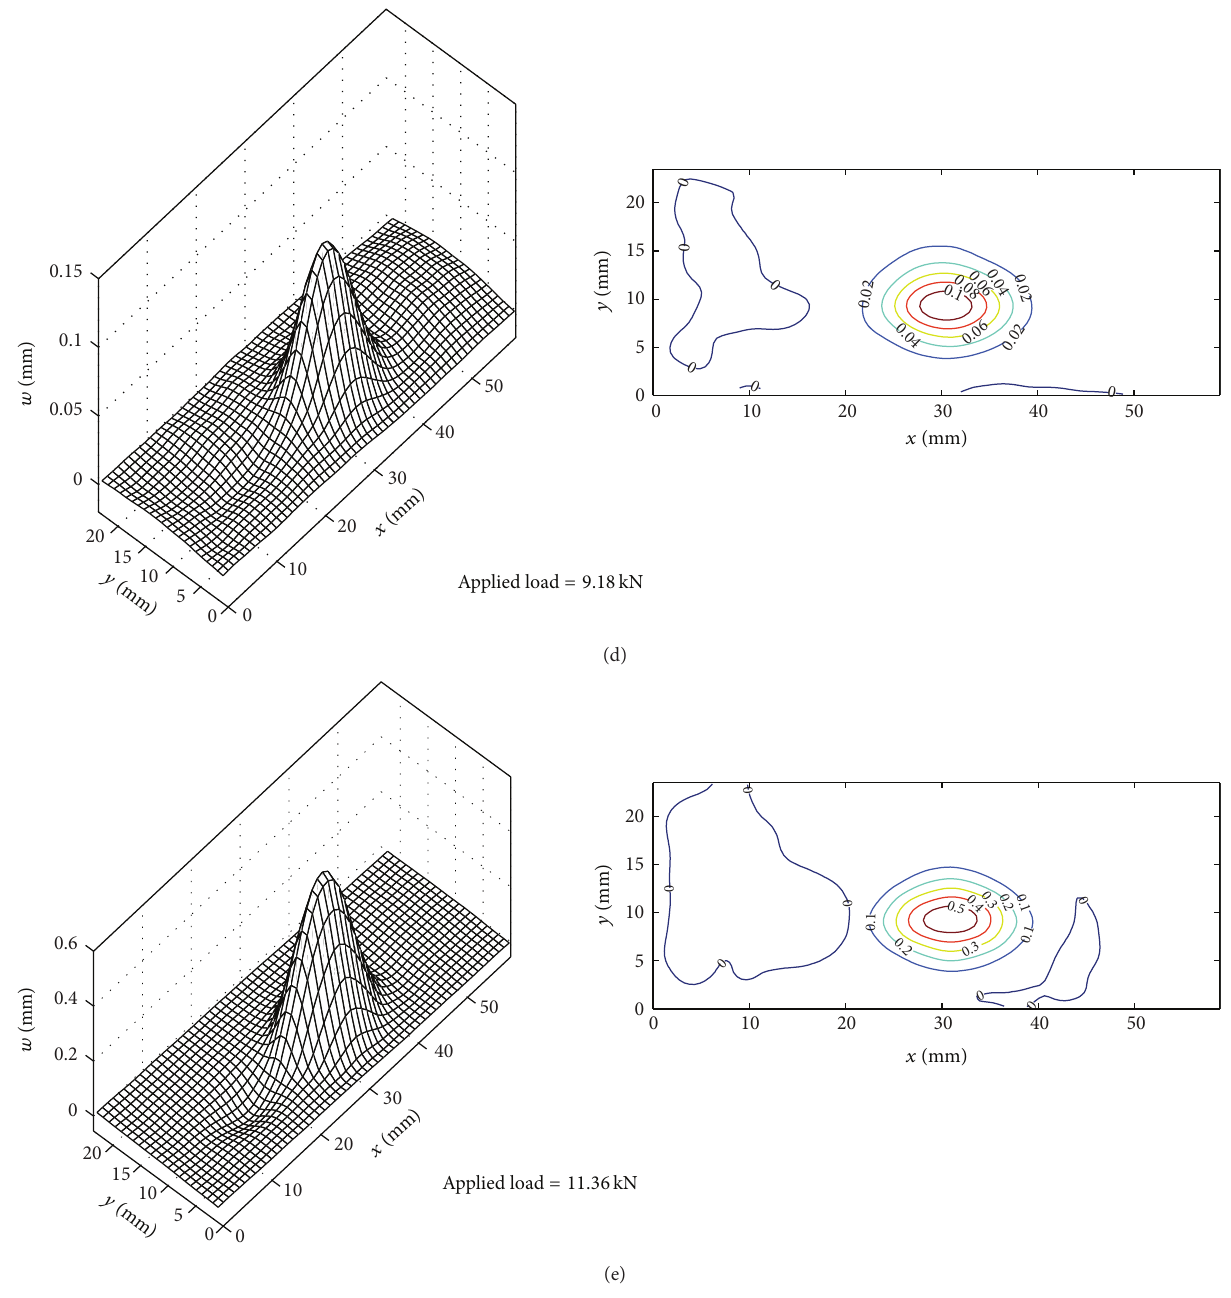
Figure 4: Measurement results of out-of-plane displacement under different load